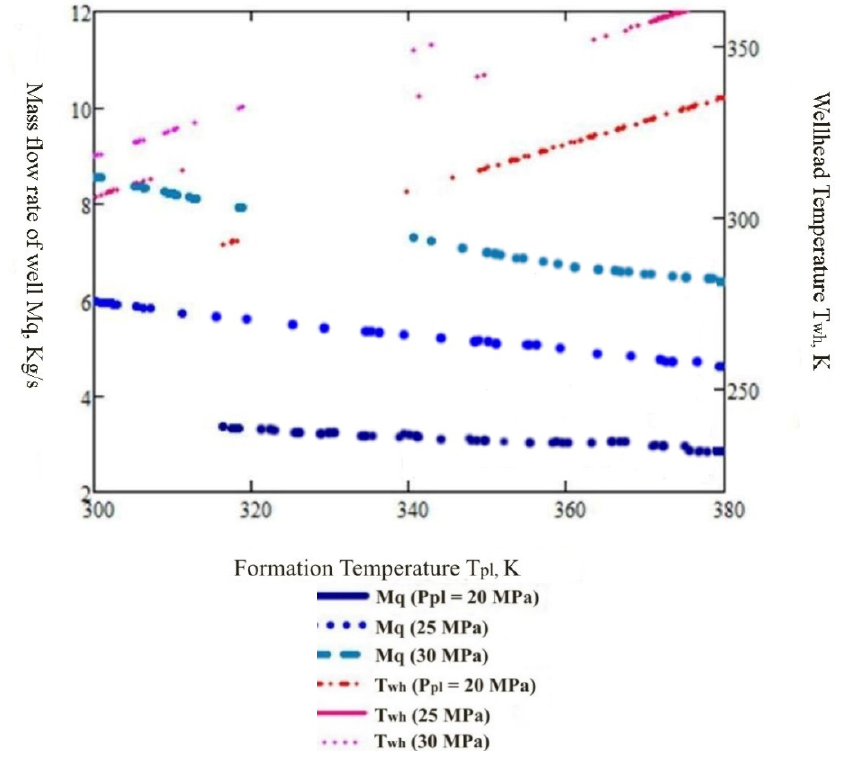
Figure 5. Dependence of M q ( T pl ) and T wh ( T pl ) taking into account the discrete change of reservoir pressure in the range of 20–30 MPa.